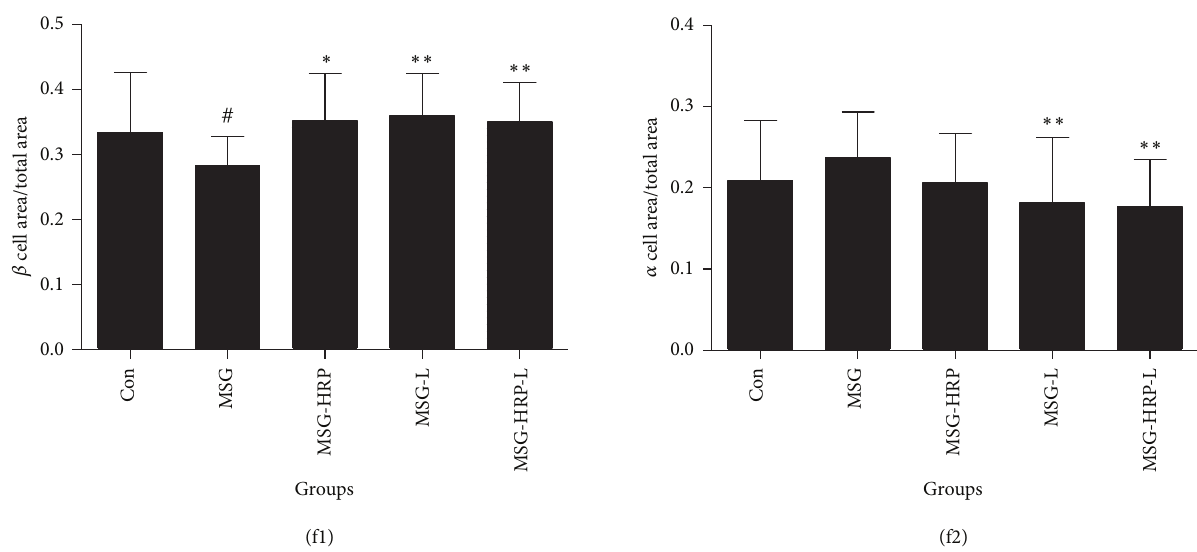
Figure 3: Insulin positive cells ((a1)–(e1)) and glucagon positive cells ((a2)–(e2)) in pancreatic islets ( × 400) and ratio of stained area ( 𝛽 -cell area and 𝛼 -cell area) to the area of whole islet ((f1) and (f2)). (a) Con; (b) MSG; (c) MSG-HRP; (d) MSG-L; (e) MSG-HRP-L; ∗ compared with